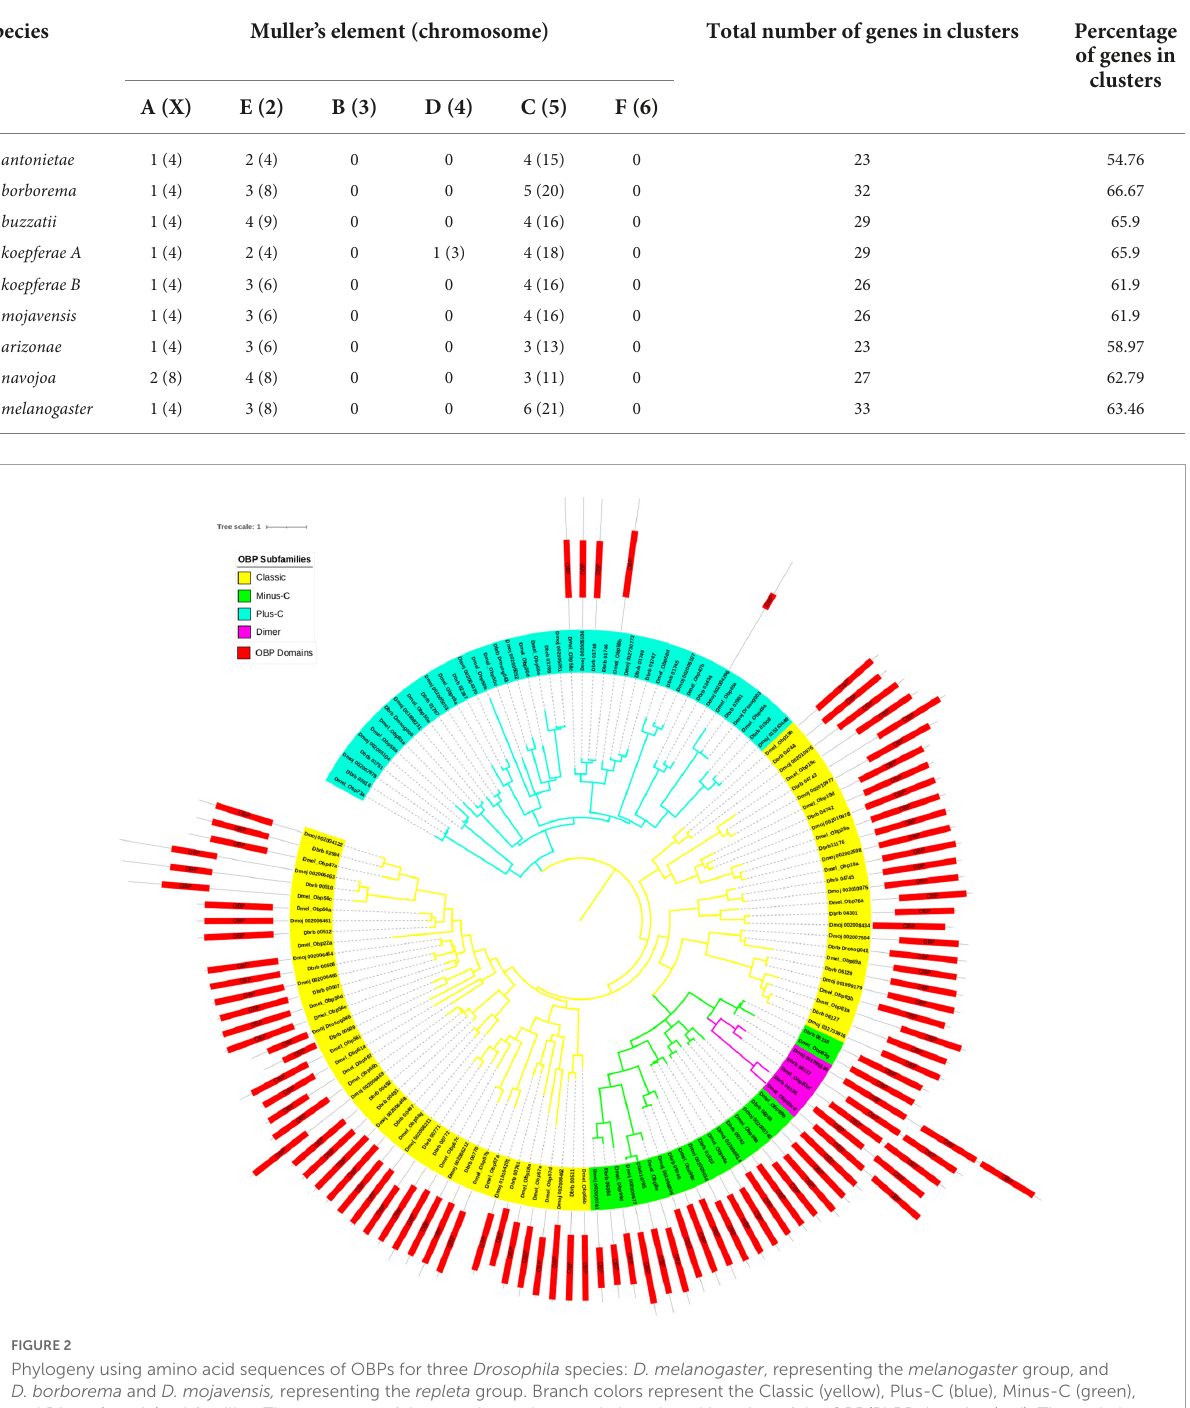
TABLE 2 Number of clusters and OBP genes (in parenthesis) across the Muller’s Elements (chromosomes) of the repleta group species. Species Muller’s element (chromosome) Total number of genes in clusters Percentage